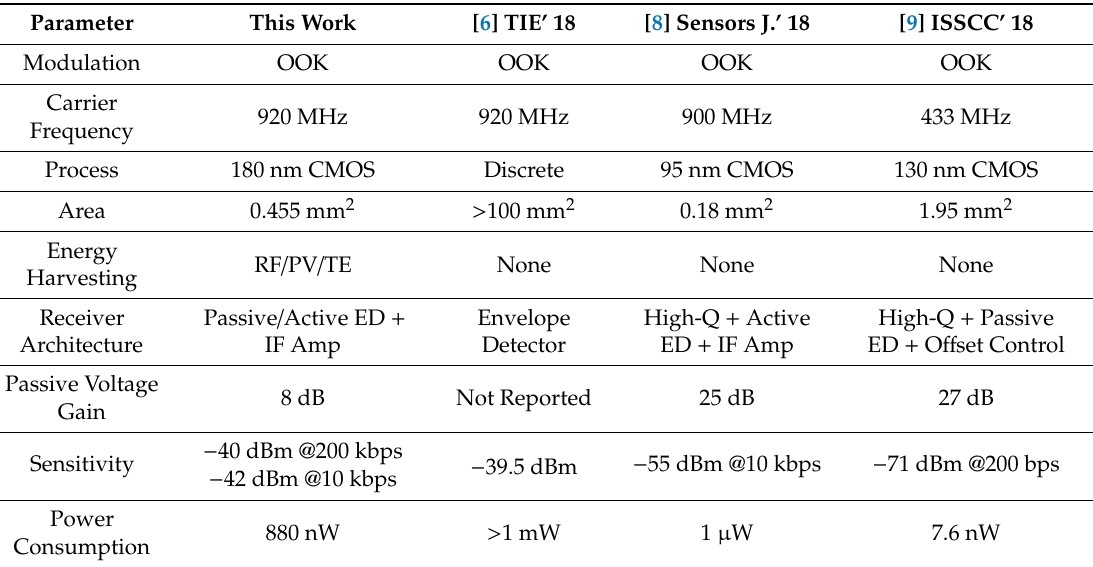
Table 1. Performance summary and comparison with related